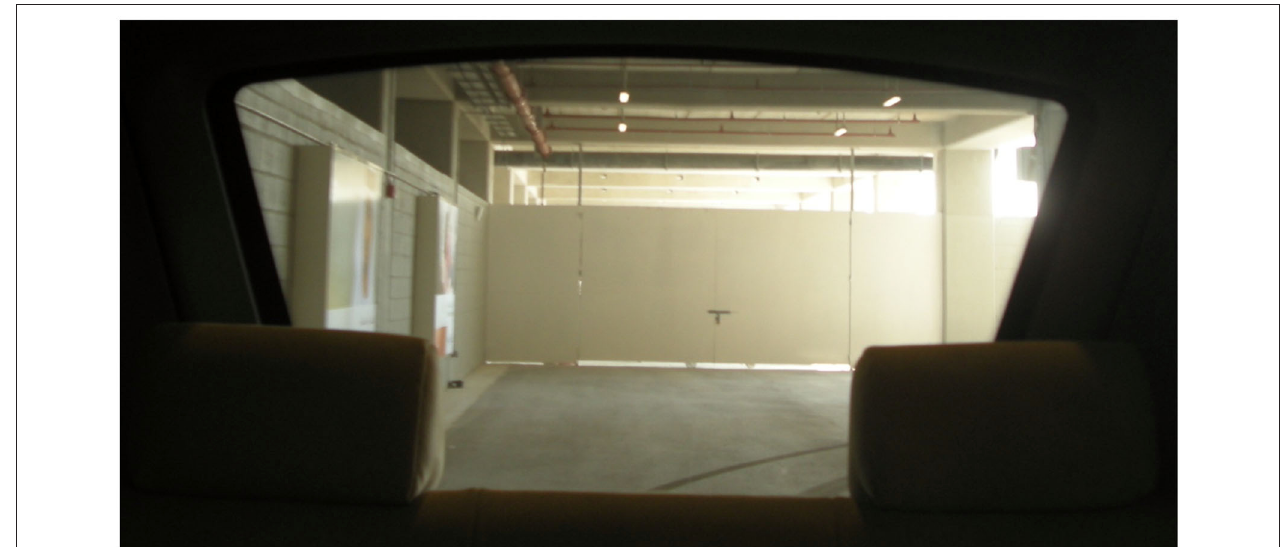
FIGURE 3 | On its way to the next station, the PRT car turns passing close to a blocked entrance leading outside Masdar City. The track that the vehicle is following is still visible on the ground. Source: author’s